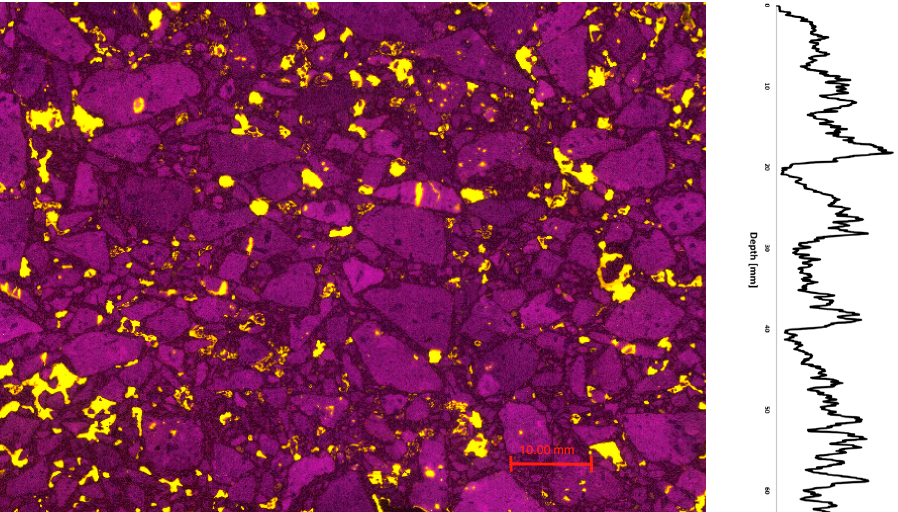
Figure 10. Grinding of asphalt concrete (AC)—asphalt petrology. Recorded scan ( left ) and vertical void distribution ( right ); area: 6.044 mm 2.